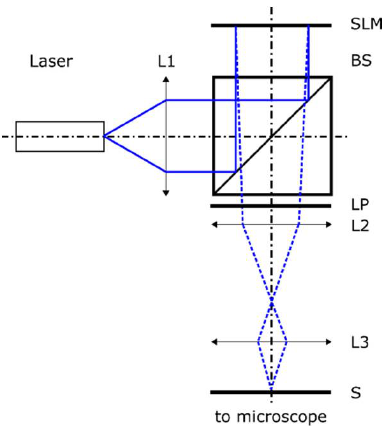
Figure 1. Schematic drawing of the setup. Laser: 450 nm laser diode. L1–L3: Lenses. BS: Non-polarizing beam splitter. Spatial light modulator (SLM): Ferroelectric liquid-crystal on silicon spatial light modulator. LP: Linear polarizer. S: Sample. Only the SLM is used for focusing on the sample.